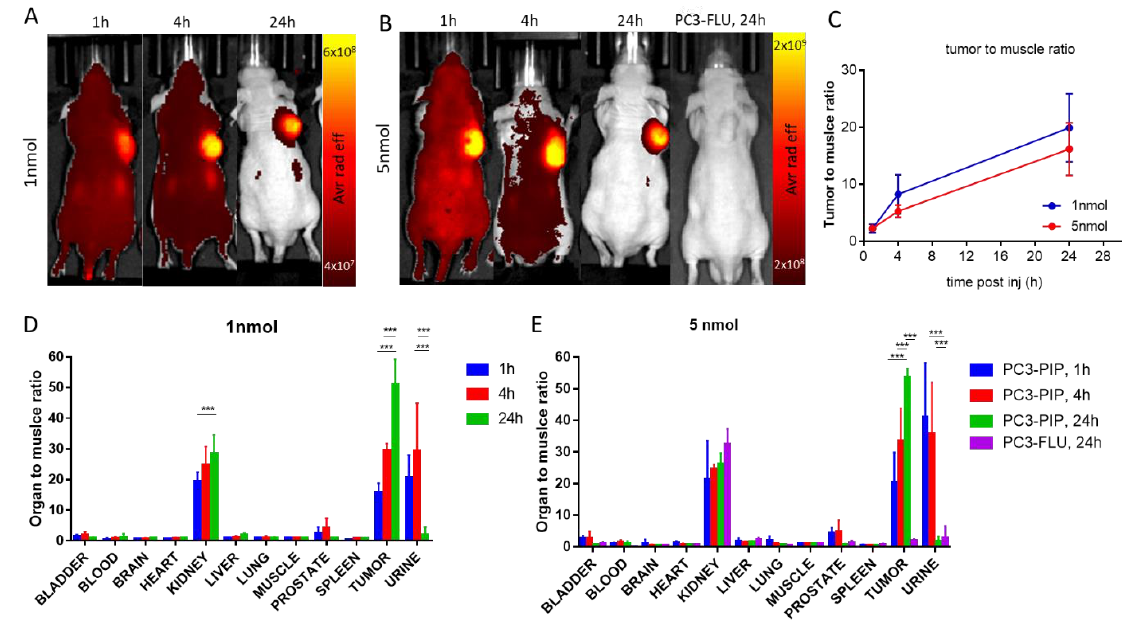
Figure 4. In vivo fluorescence imaging of PC3-PIP and PC3-FLU tumour bearing mice. ( A ) Representative in vivo optical images of PC3-PIP tumour bearing mice 1 h, 4 h and 24 h after administration of 1 nmol of IRDye700-PSMA (n = 4 group), λ exc = 640 nm (30 nm bandwidth, λ em = 720 nm. (20 nm bandwidth); ( B ) Representative in vivo optical images of PC3-PIP tumour bearing mice 1 h, 4 h and 24 h and PC3-FLU tumour bearing mice 24 h after administration of 5 nmol of IRDye700-PSMA (n = 4 group), λ exc = 640 nm (30 nm bandwidth, λ em = 720 nm. (20 nm bandwidth); ( C ) in vivo optical imaging signal ratio of tumour and muscle region at different timepoint after injection; ( D ) Ex vivo optical imaging of different organs after 1 nmol administration; ( E ) Ex vivo optical imaging of different organs after 5 nmol administration. *** p < 0.0001, 2-way ANOVA repeated measures followed by Bonferroni post hoc test.